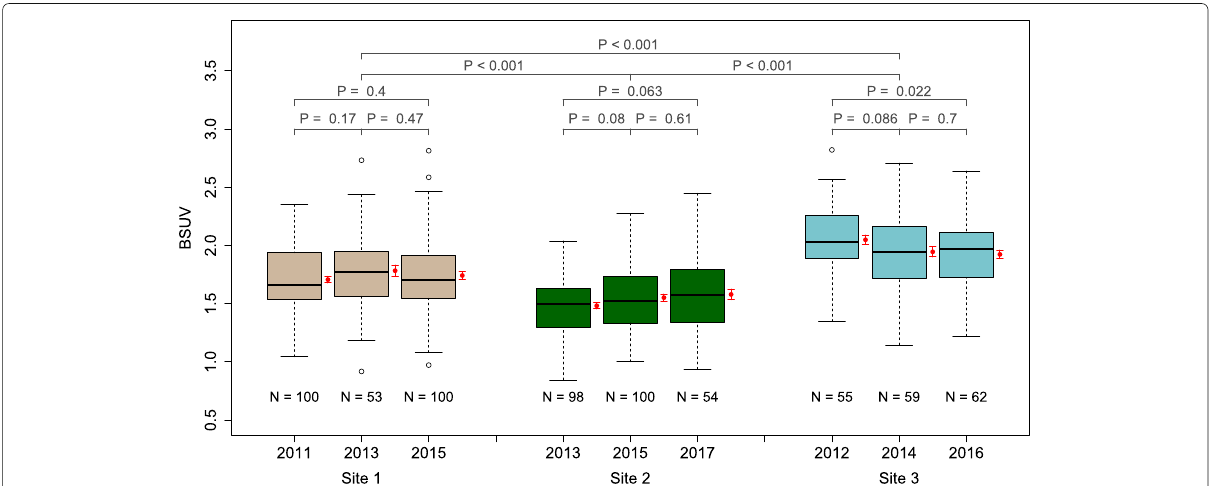
Fig. 3 Boxplot of the derived BSUV distributions in the different patient groups and sites. Significance levels for group and site differences are indicated. Group averaged BSUV is shown in red beside the respective box (error bars represent the standard error of the mean)